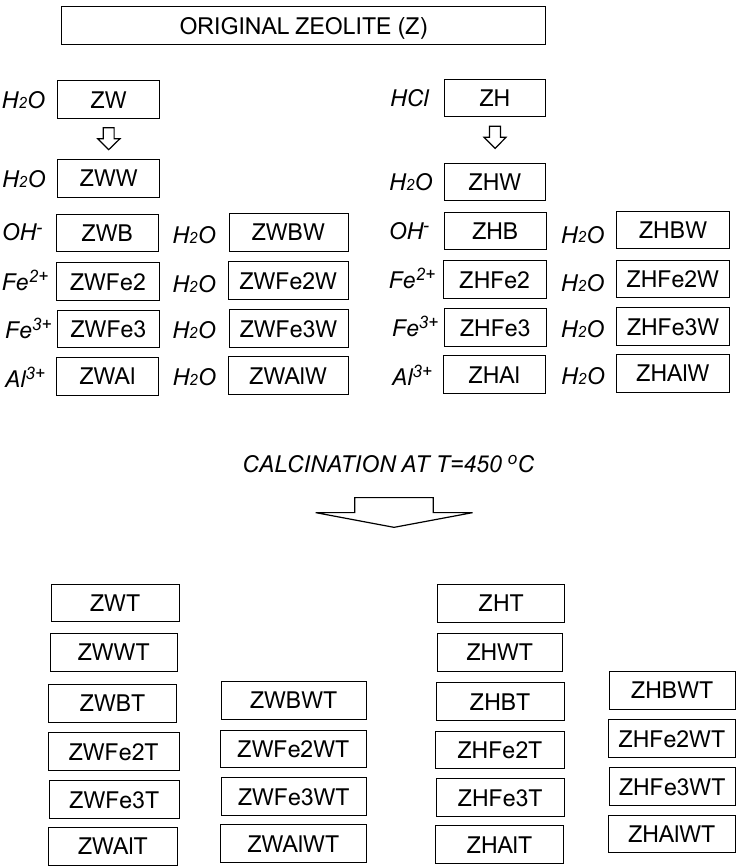
Figure 1. Scheme of the sample preparation. The treatments are written in italic. Abbreviation of the samples obtained after each treatment are closed within rectangles.